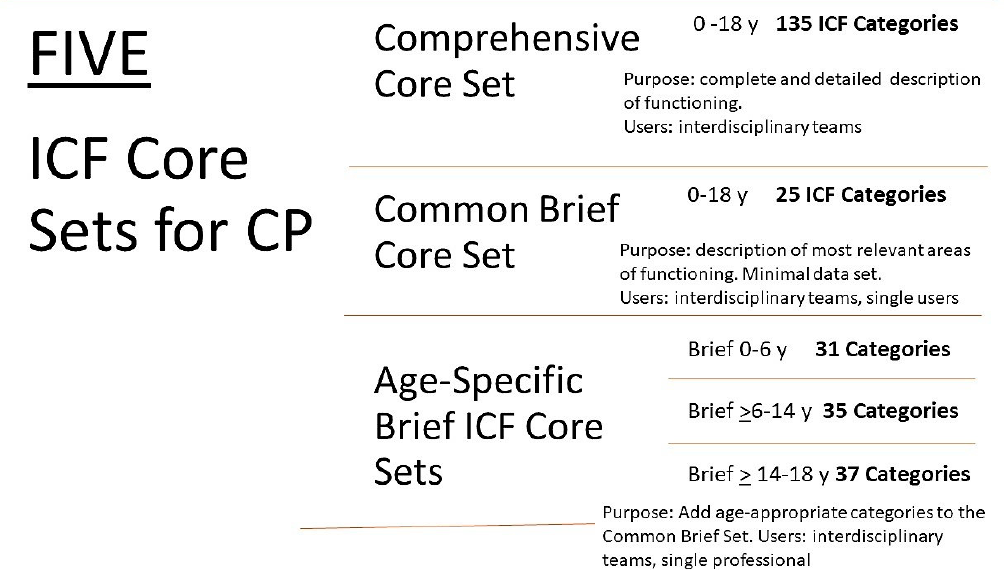
Figure 1. International Classification of Functioning, Disability, and Health (ICF) Core Sets for children and youth with Cerebral Palsy.